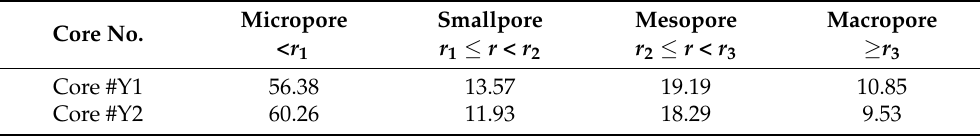
Table 3. Pores’ volume ratio of different scales